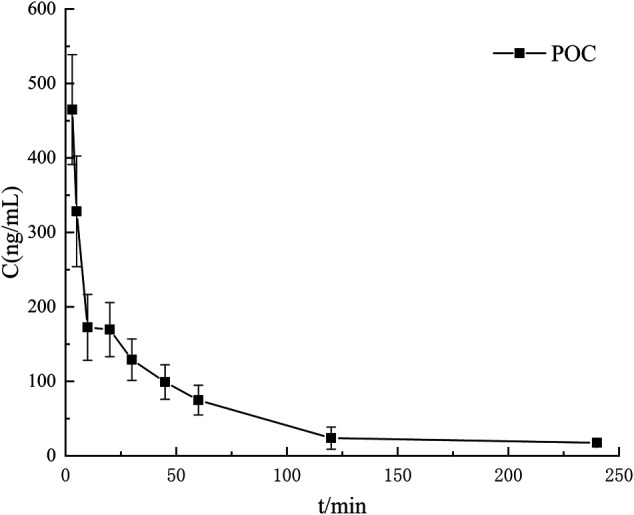
PK study. Concentration-time profiles after intravenous injection of POC solution.